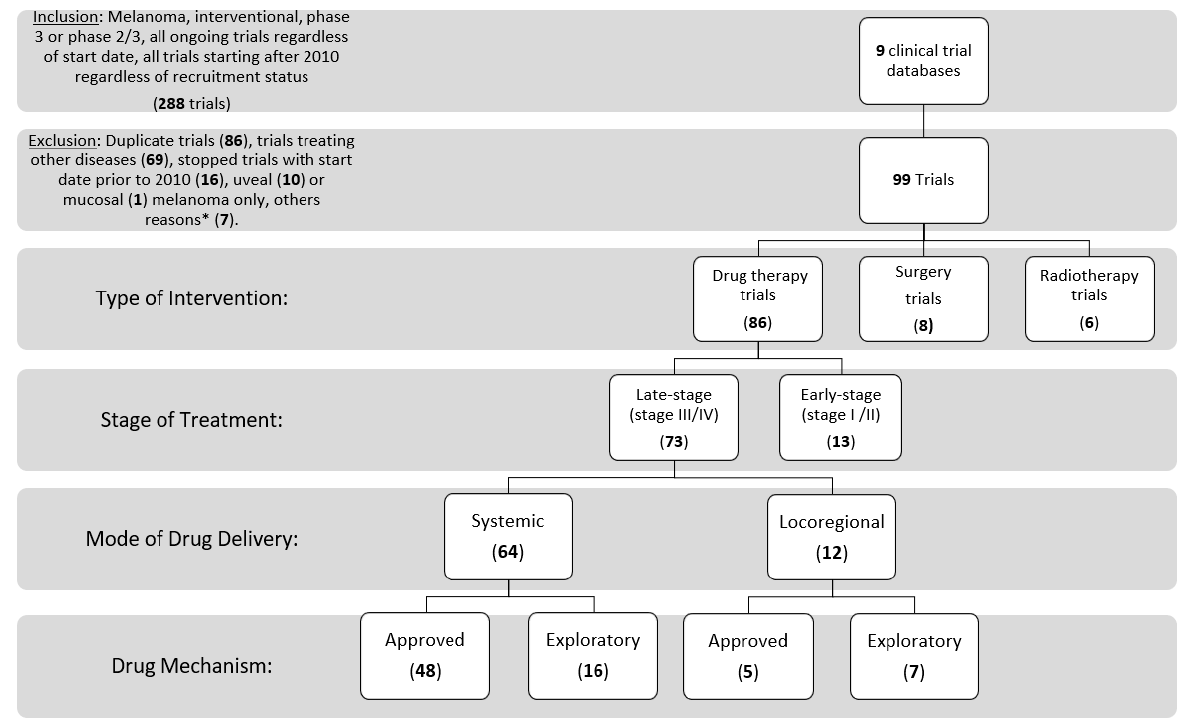
Figure 2. Consort diagram of trial inclusion and exclusion, and categorization. * Other reasons include having trials still listed as phase 2 on clinicaltrials.gov (3), Extension study of an included trial (1), phase 4 (1), anticipated start date 1987 (1), and a supportive trial